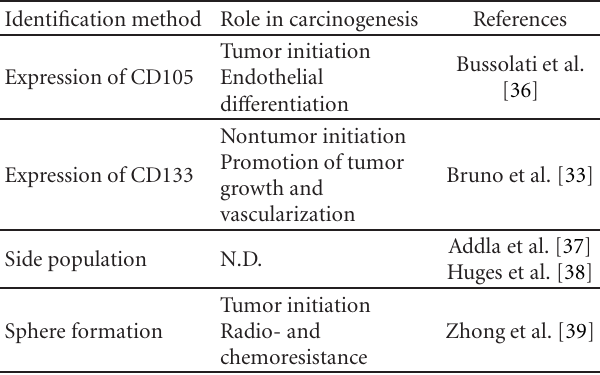
Table 1: Di ff erent populations of stem cells identified in human renal carcinomas and role in tumor growth. N. D.: not